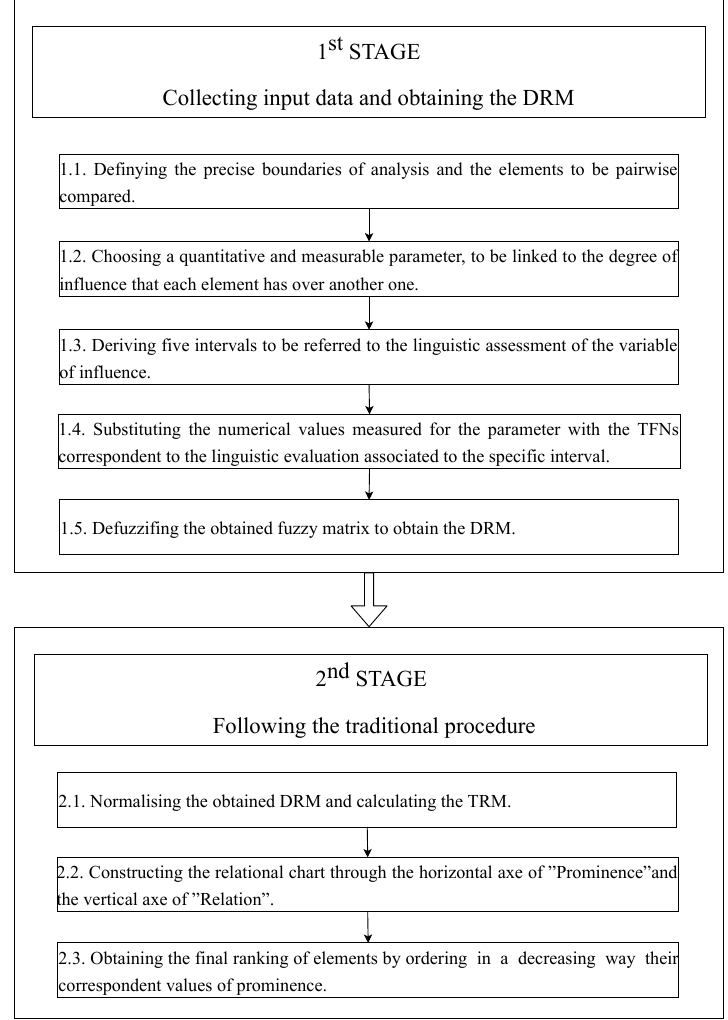
Figure 1. Flowchart of the modified fuzzy DEMATEL